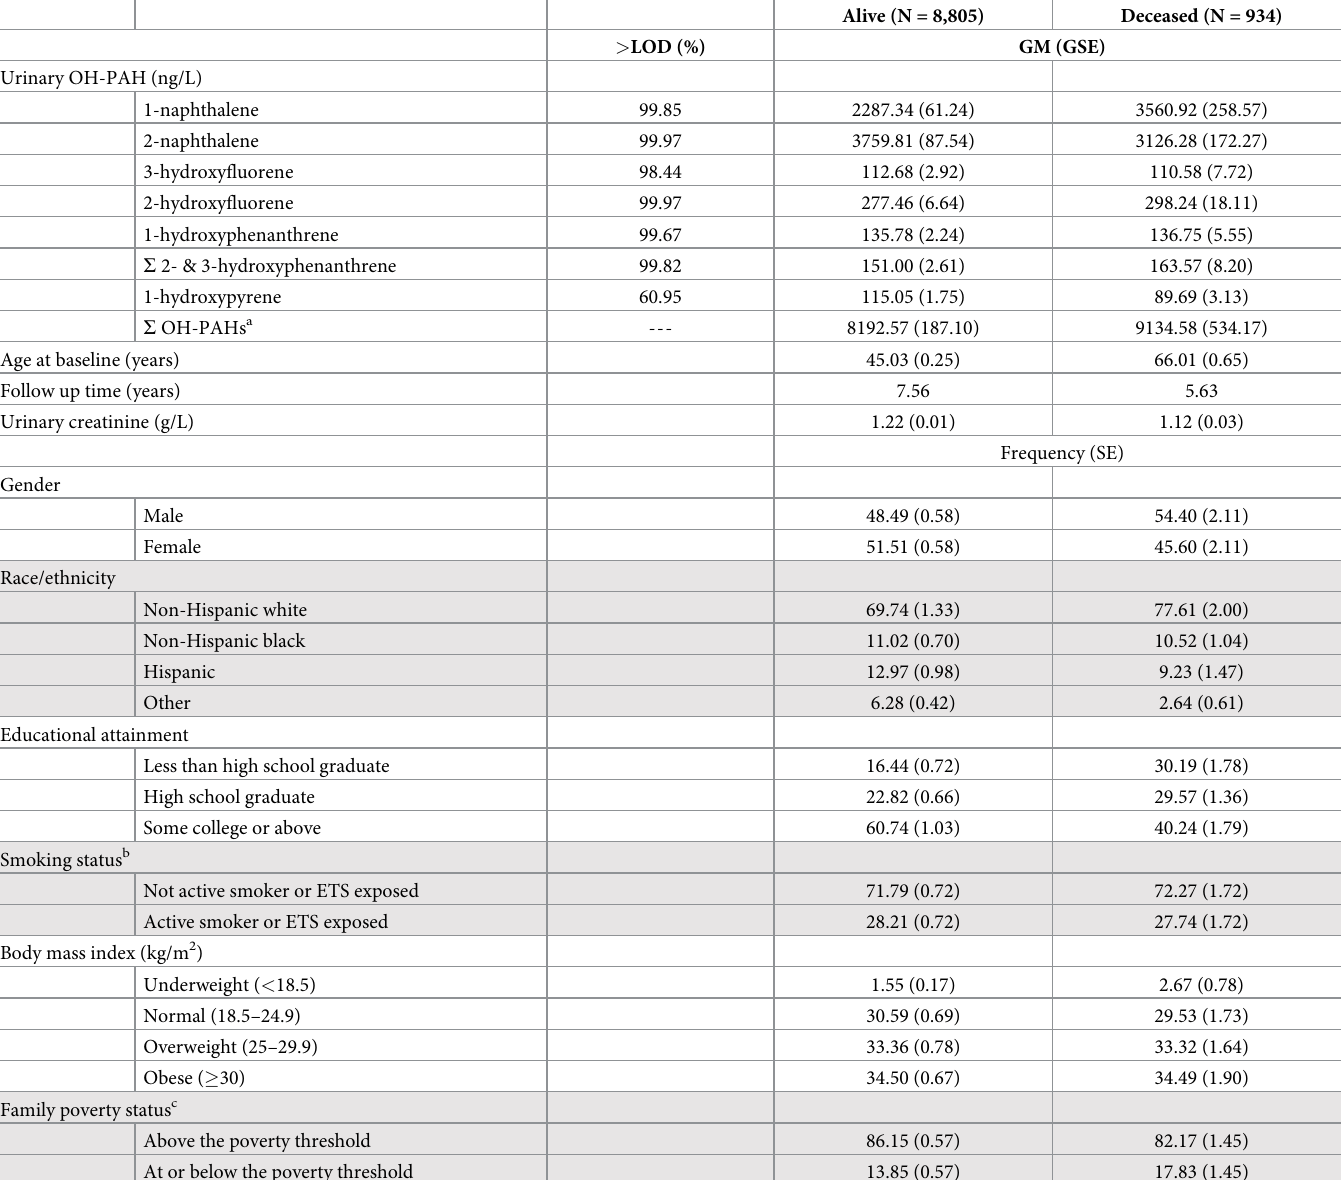
Table 1. Baseline descriptive characteristics in NHANES 2001–2014 (N = 9,739) by mortality